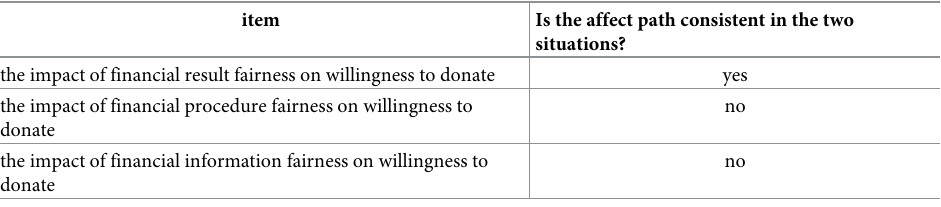
Table 11. Consistency comparison of significance. item Is the direct impact significance consistent in the two the impact of financial result fairness on willingness to donate the impact of financial procedure fairness on willingness to donate the impact of financial information fairness on willingness to donate